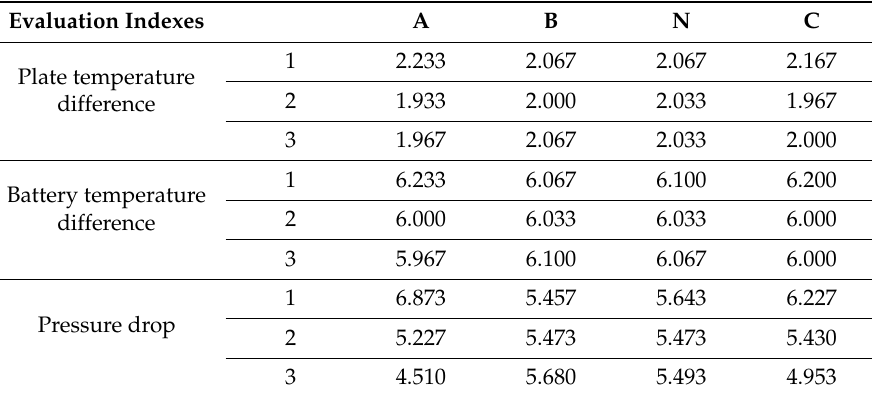
Table 6. Range analysis of the evaluation indexes.